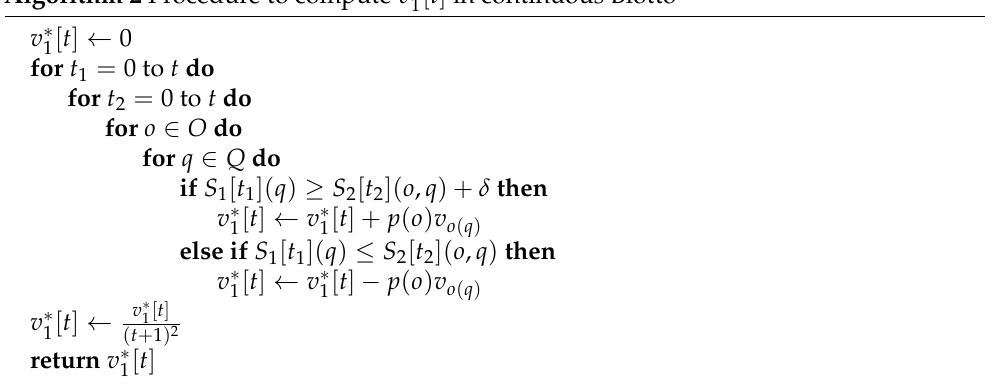
Algorithm 2 Procedure to compute v ∗